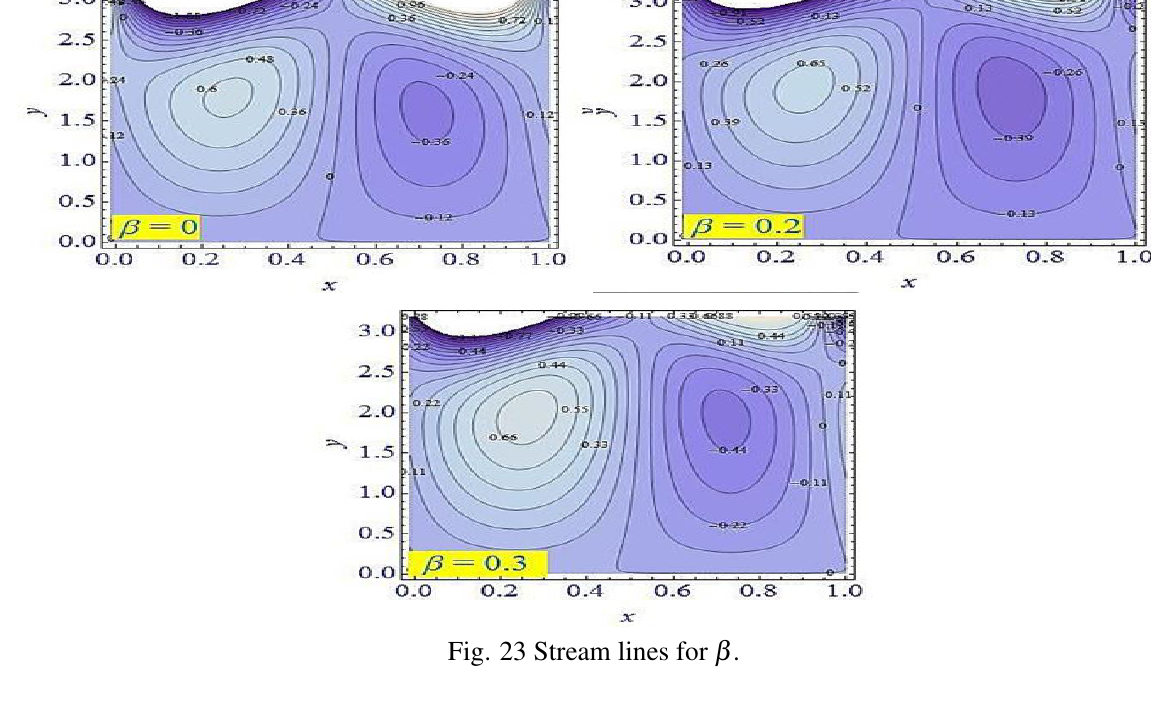
Fig. 23 Stream lines for β .